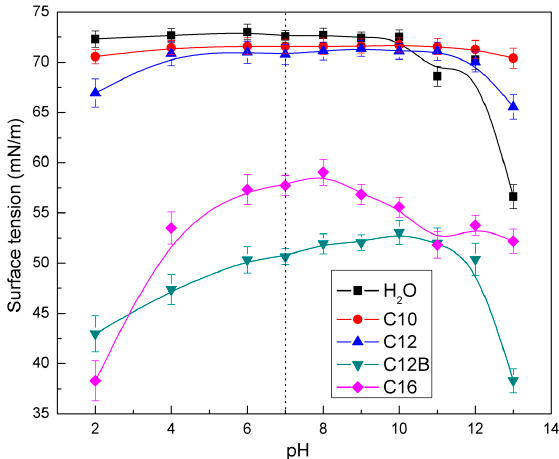
Figure 5. Surface tension of the collector solutions compared with water, as a function of the pH.